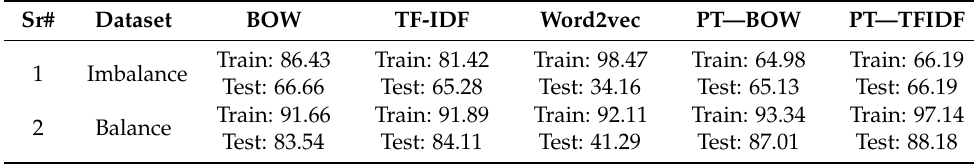
Table 3. Results of Naive